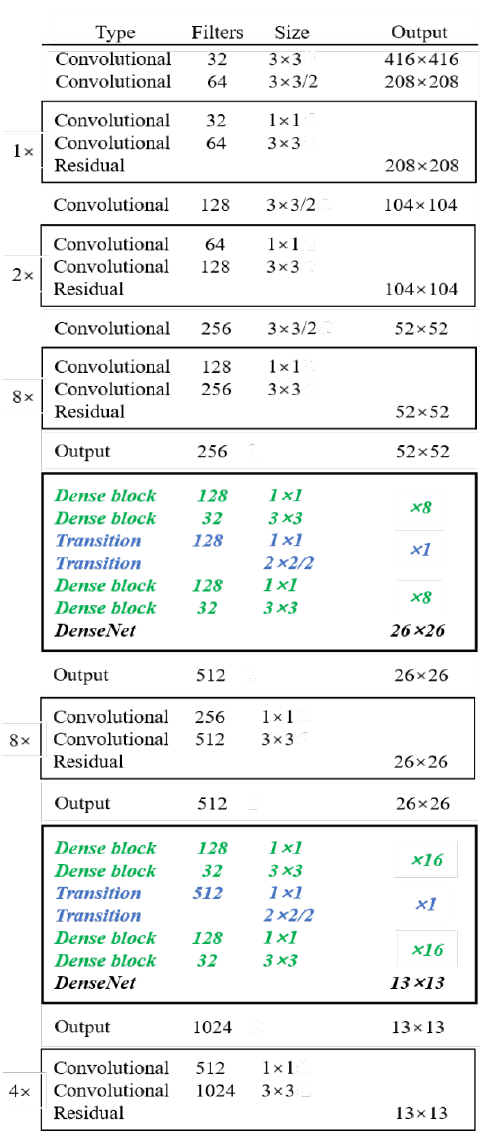
Figure 4. Network structure diagram of proposed YOLOV3-dense model.